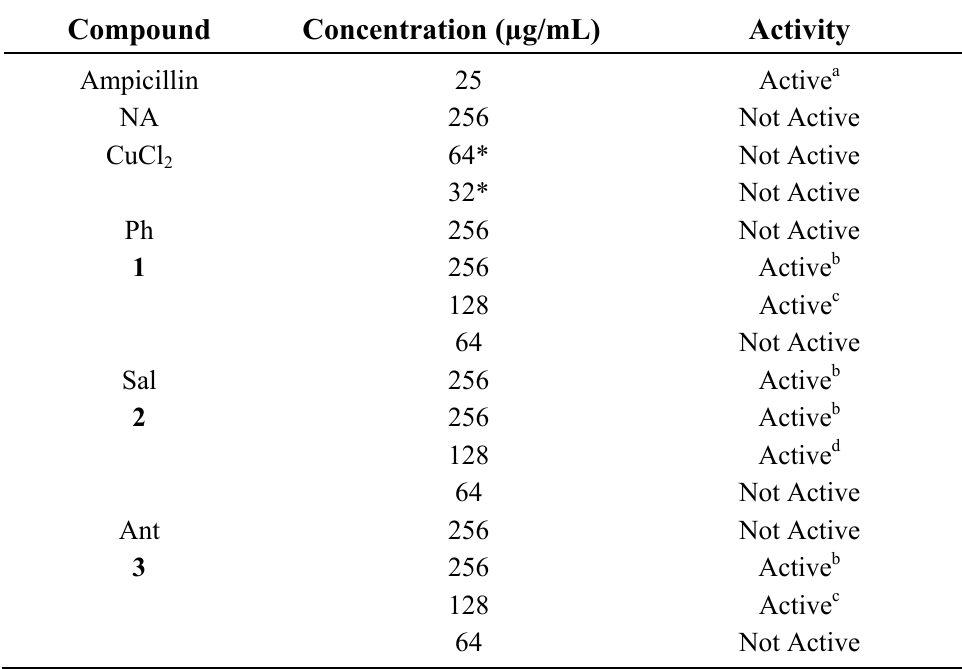
Table 4. Antimicrobial activity of the free ligands and nicotinic acid-copper